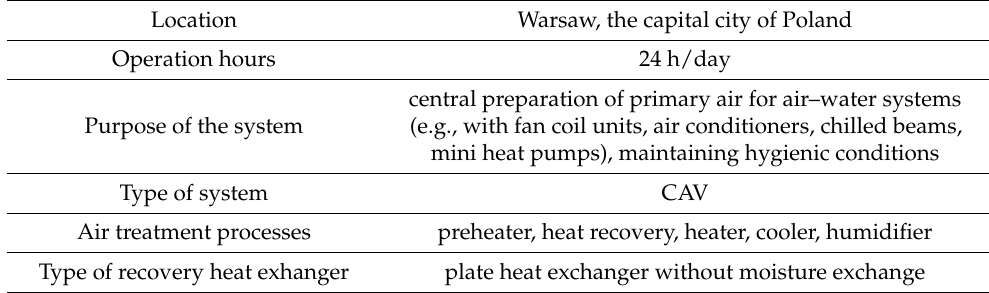
Table 4. Main assumptions of the air treatment system.